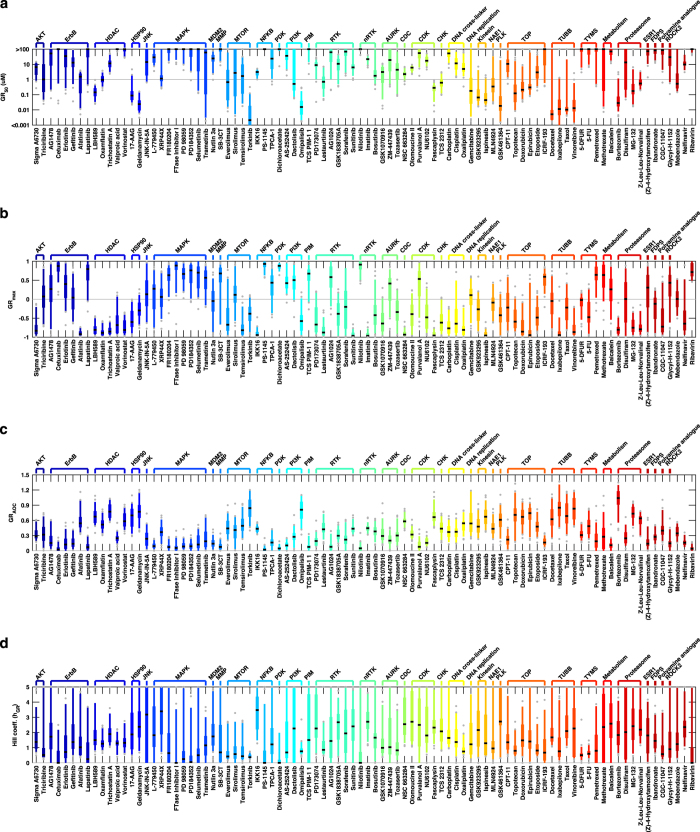
Distribution of the GR metrics by drug for all analyzed cell lines (averaged across biological replicates).(a) GR50 values. (b) GRmax values. (c) GRAOC. (d) Hill coefficient (hGR).